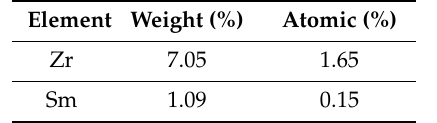
Table 5. Quantitative EDS analysis results obtained from point 1 on the surface of the sample presented in Figure 8b (data only for Zr and Sm)